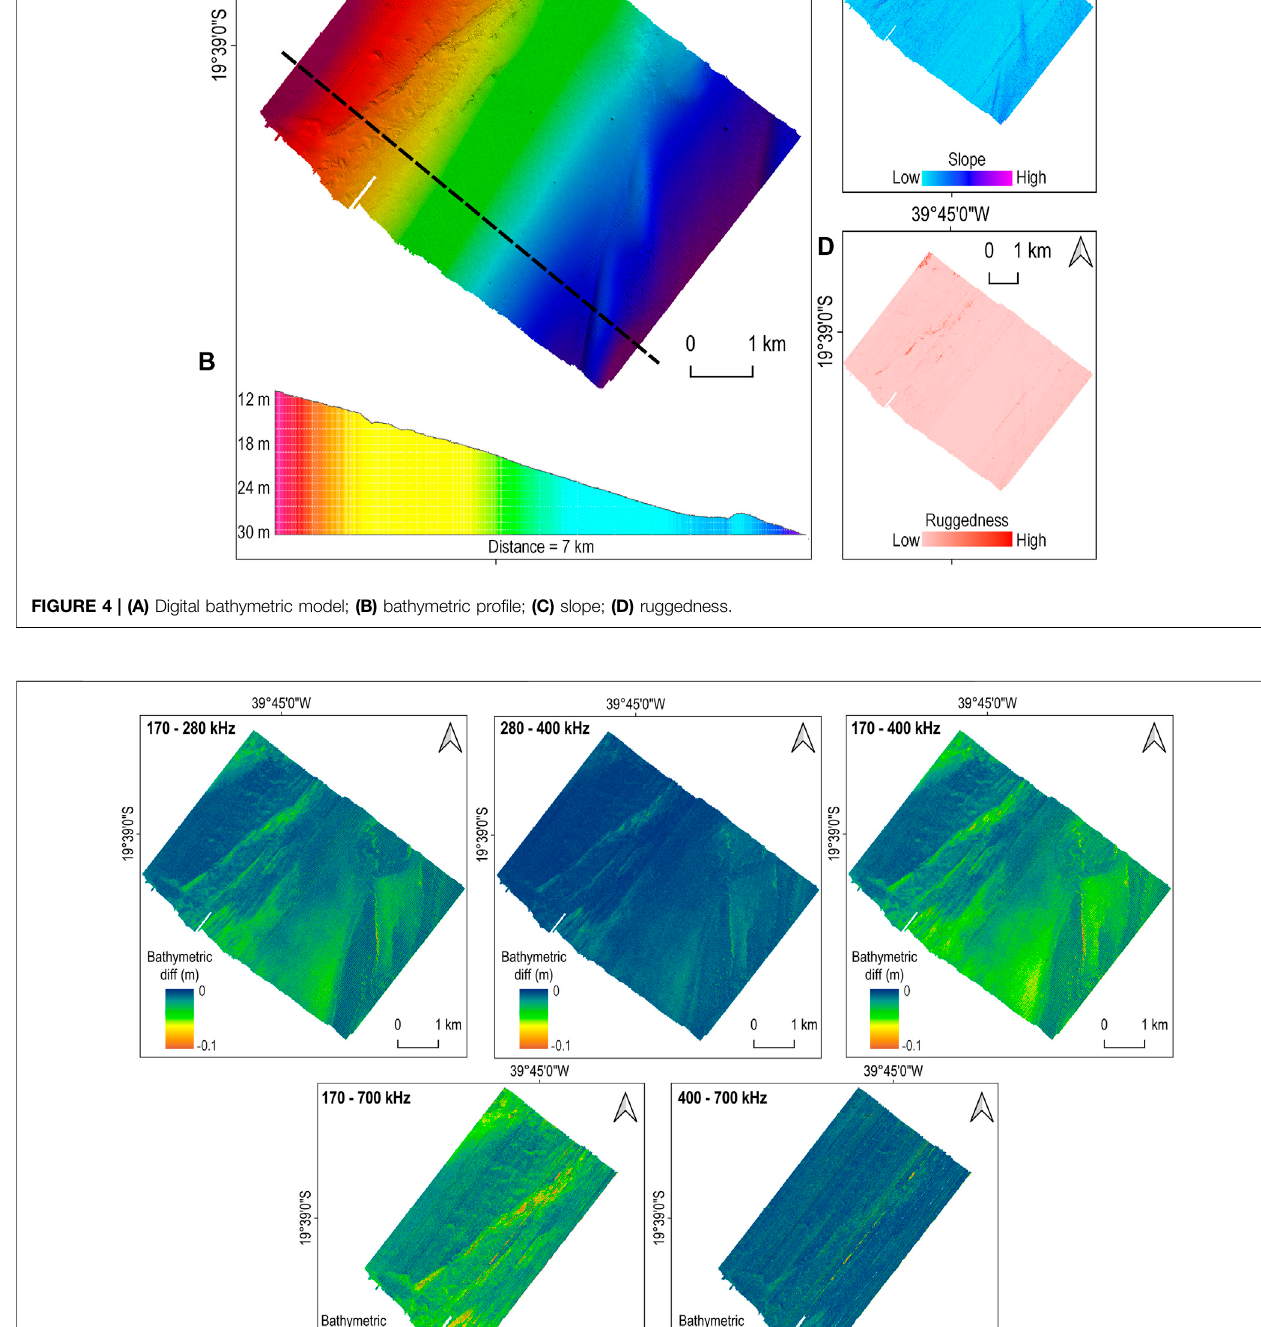
Frontiers in Remote Sensing |